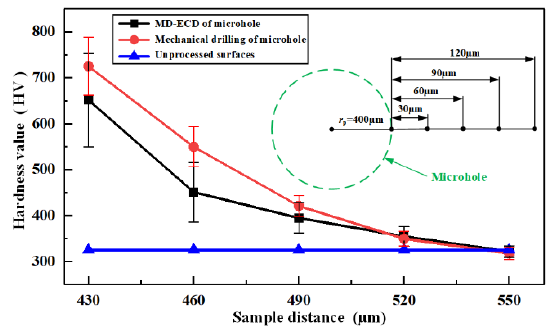
Figure 17. Micro-hardness of the microhole.